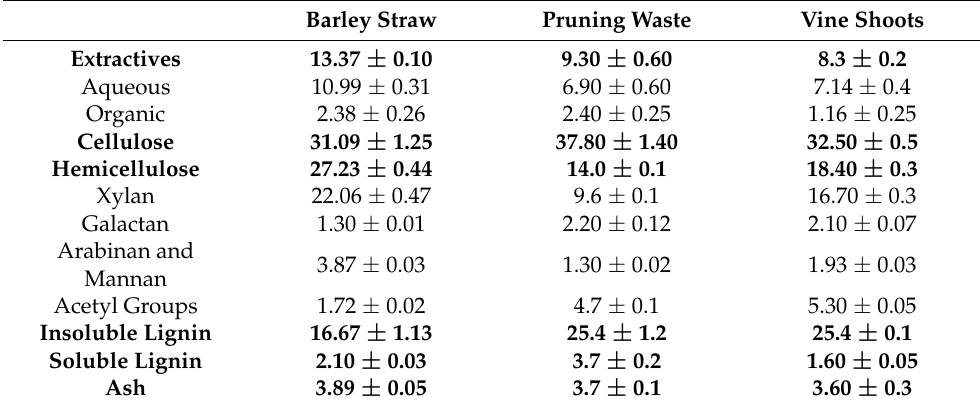
Table 1. Composition results (wt.%) of the different lignocellulosic biomasses dried at 105 ◦ C. Barley Straw